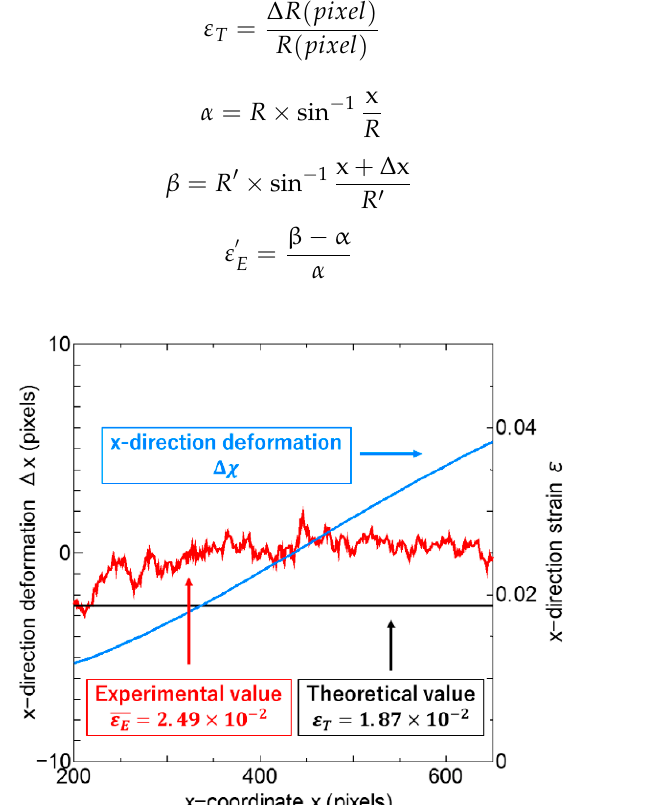
Figure 5. X-direction deformation and deviation between the distribution map for the region of interest theoretical and experimentally measured values of strain.